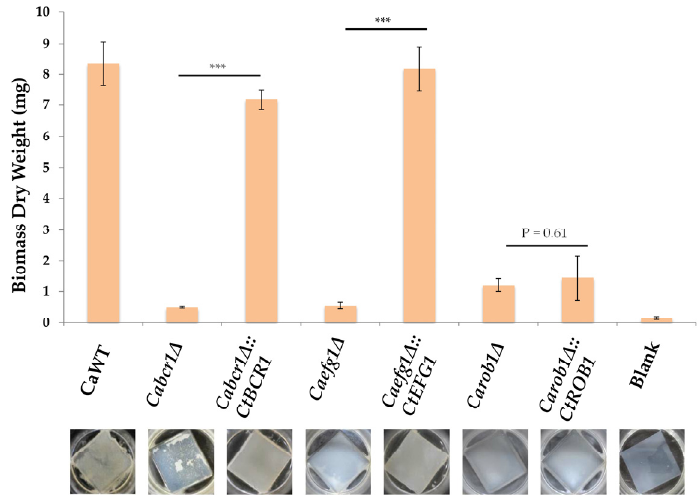
Figure 6. Heterogeneous expression of C. tropicalis ROB1 in the C. albicans rob1 Δ could not recover biofilm growth. Values are the mean ± SD from three replicates. Reintroduction of CtBCR1 and CtEFG1 into C. albicans bcr1 Δ and efg1 Δ strains, respectively, restored biofilm development in C. albicans , whereas Carob1 Δ ::CtROB1 exhibited few biofilms. *** p < 0.001.